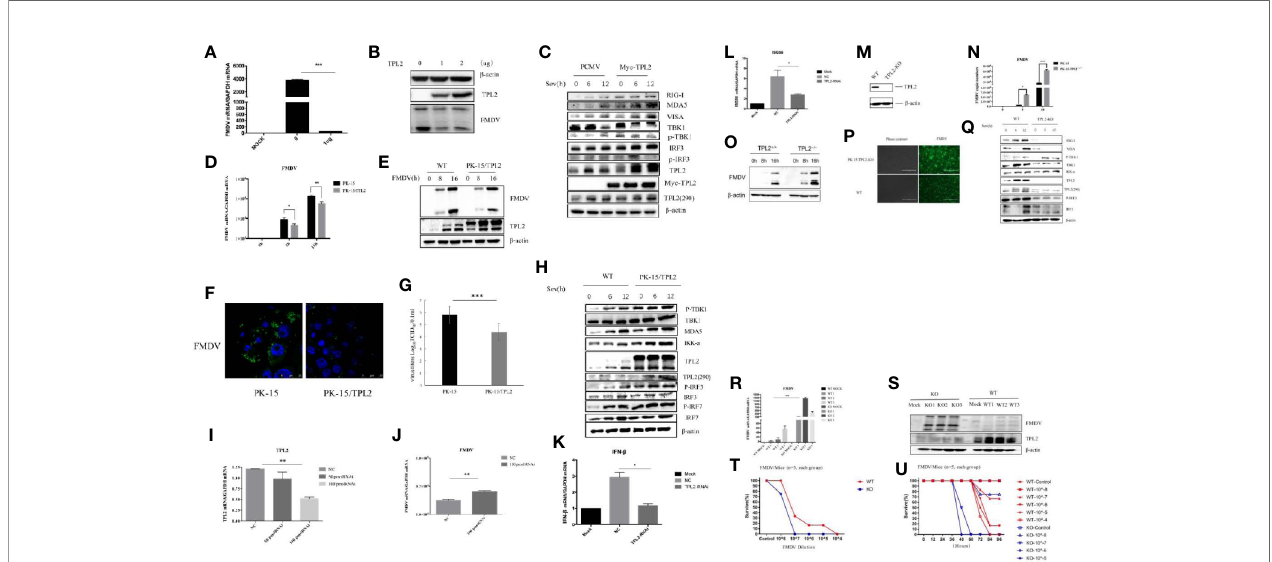
FIGURE 1 | Host TPL2 inhibits the replication of FMD virus (FMDV). (A, B) The PK-15 cell line was transfected with 0 m g and 1 m g of Myc-TPL2 plasmid. Twenty- four hours after transfection, cells were infected with FMDV (MOI = 0.5). Virus titer was evaluated 12 h later using real-time qPCR (qRT-PCR) and Western blotting (WB). (C) HEK293T cells were transfected with 5 m g each of the plasmids. Twenty-four hours after transfection, the cells were infected with SeV and then evaluated after 0, 6, and 12 h. WB was performed to detect immunoreactive RIG-I, MDA5, VISA, TBK1, P-TBK1, IRF3, IRF7, and phosphorylated at Thr290 [TPL2 (290)]. (D, E) The PK-15/TPL2 cell line that stably expresses TPL2 and WT PK-15 cells were collected at 0, 8, and 16 h after infection with FMDV (MOI = 0.5). FMDV replication was evaluated by qRT-PCR and WB. (F) PK-15/TPL2 and WT PK-15 cells were infected with FMDV and analyzed after 16 h using IFA. (G) PK-15/TPL2 and WT PK-15 cells were infected with FMDV (MOI = 0.5); viral titers were determined using the 50% tissue culture infective dose (TCID 50 ) assay. (H) PK-15/TPL2 and WT PK-15 cells line were collected at 0, 6, and 12 h after SeV infection for detection of immunoreactive RIG-I, MDA5, VISA, TBK1, P-TBK1, IRF3, IRF7, TPL2 (290) by WB. (I) Effect of TPL2-RNAi plasmid on the expression of the endogenous TPL2 gene. (J) TPL2-RNAi plasmid was transfected into PK-15 cells. After 24 h, the transfected cells were infected with FMDV (MOI = 0.5); qRT-PCR was performed to evaluate FMDV-associated gene transcription. (K, L) WT or TPL2-RNAi-transfected HEK293T cells were infected with SeV; 12 h later, transcription of genes encoding IFN- b and ISG56 was evaluated by qRT-PCR. (M) WB evaluated the TPL2 protein level in TPL2 gene-deleted PK-15 cells. (N, O) TPL2 gene-deleted PK-15 cells were infected with FMDV (MOI = 0.5). Cells were collected 0, 8, and 16 h later to evaluate virus titer and FMDV-associated gene transcription by qRT-PCR. (P) WT and TPL2 gene-deleted PK-15 cells were infected with FMDV (MOI = 0.5); after 16 h, cells were evaluated by immuno fl uorescence (IFA). (Q) WT PK-15 and TPL2 gene-deleted PK-15 cells were mock-infected or infected with SeV and collected at 0, 6, and 12 h to evaluate phosphorylation of immunoreactive RIG-I, MDA5, VISA, TBK1, P-TBK1, IRF3, IRF7, and TPL2 (290) by WB. (R, S) FMDV replication was evaluated in WT and Tpl2 - /- suckling mice by qRT-PCR and WB. (T, U) Survival of WT and Tpl2 - /- suckling mice was evaluated after intramuscular injection of 7×104 pfu of